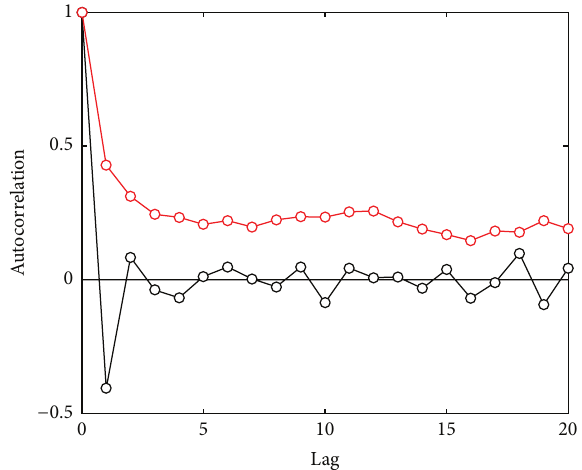
Figure 5: Autocorrelation function of the simulated stock 2. The black line shows the autocorrelation function of the returns. The red line is the autocorrelation of the absolute